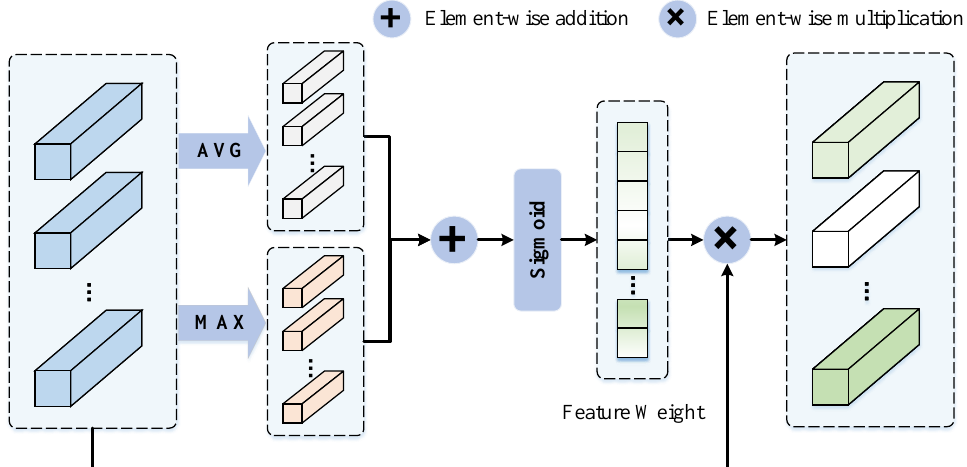
Figure 6. The framework of the AFS block. The AFS block adaptively selects more important local subfeatures by generating a set of feature